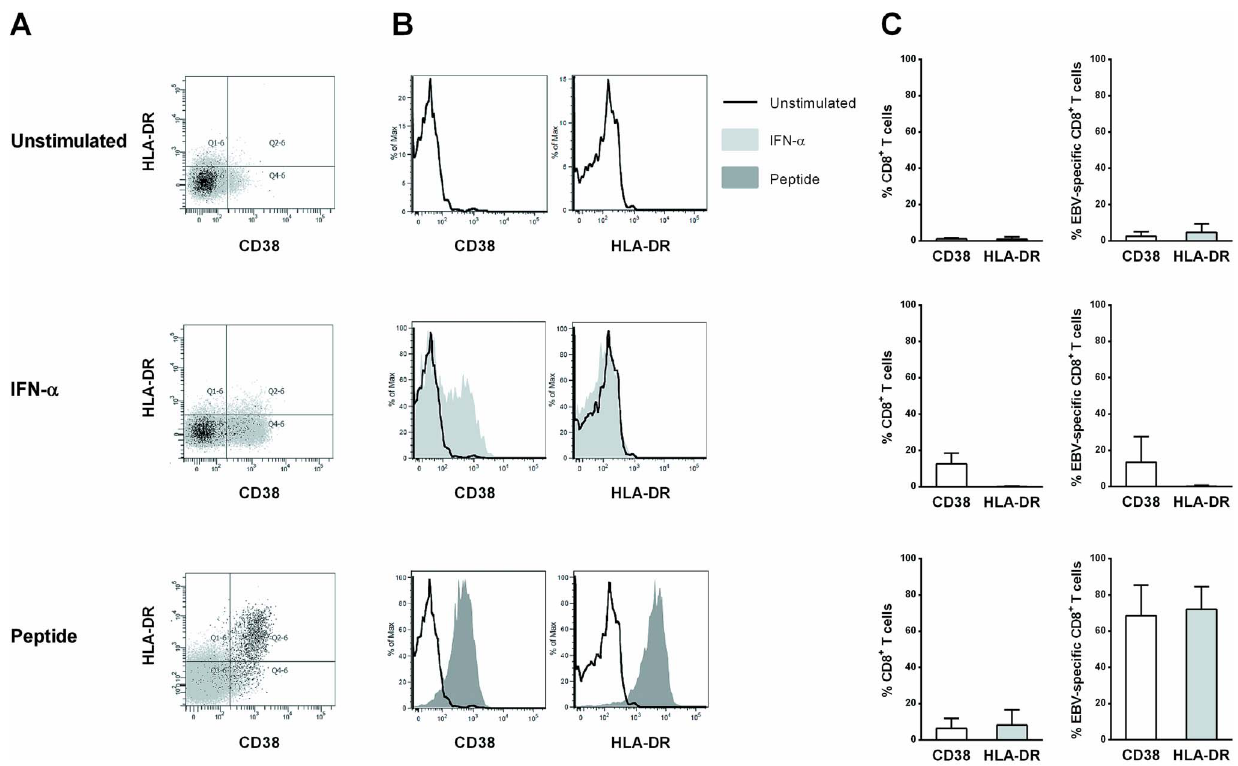
Figure 4. Influence of stimulatory conditions on the activation phenotype of specific CD8 + T cells. (A) Representative dot plots of HLA- DR and CD38 expression in unstimulated conditions (upper graph), after IFN- a stimulation (middle graph) or peptide stimulation (2 m M, lower graph) among specific (dark dots) and non-specific (gray dots) CD8 + T cells from healthy donors after a four-day culture period. CD38 and HLA-DR expression on bulk (C left panel) and specific CD8 + T cells (B and C right panel). (B) Flow cytometry histograms showing representative results for cells from one individual in unstimulated conditions (dark lines), after IFN- a stimulation (light gray histograms) or peptide stimulation (dark gray histograms). (C) Surface expression of CD38 (white bars) and HLA-DR (gray bars) on bulk and specific CD8 + T cells (n=4).